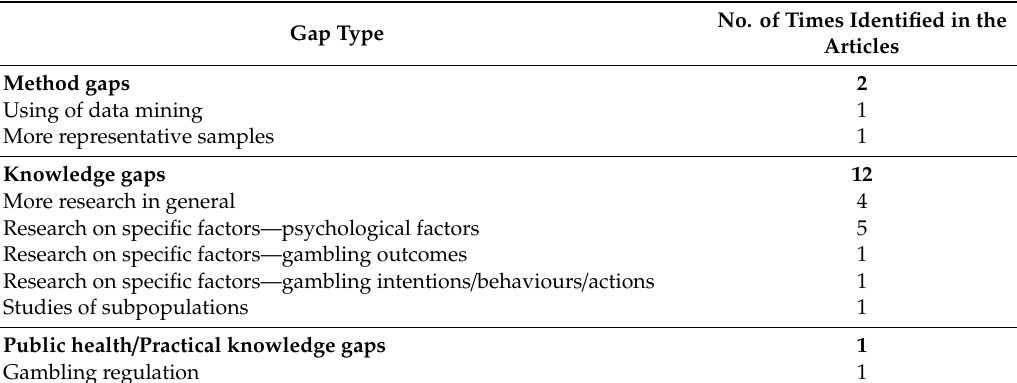
Table 8. Electronic gaming machines